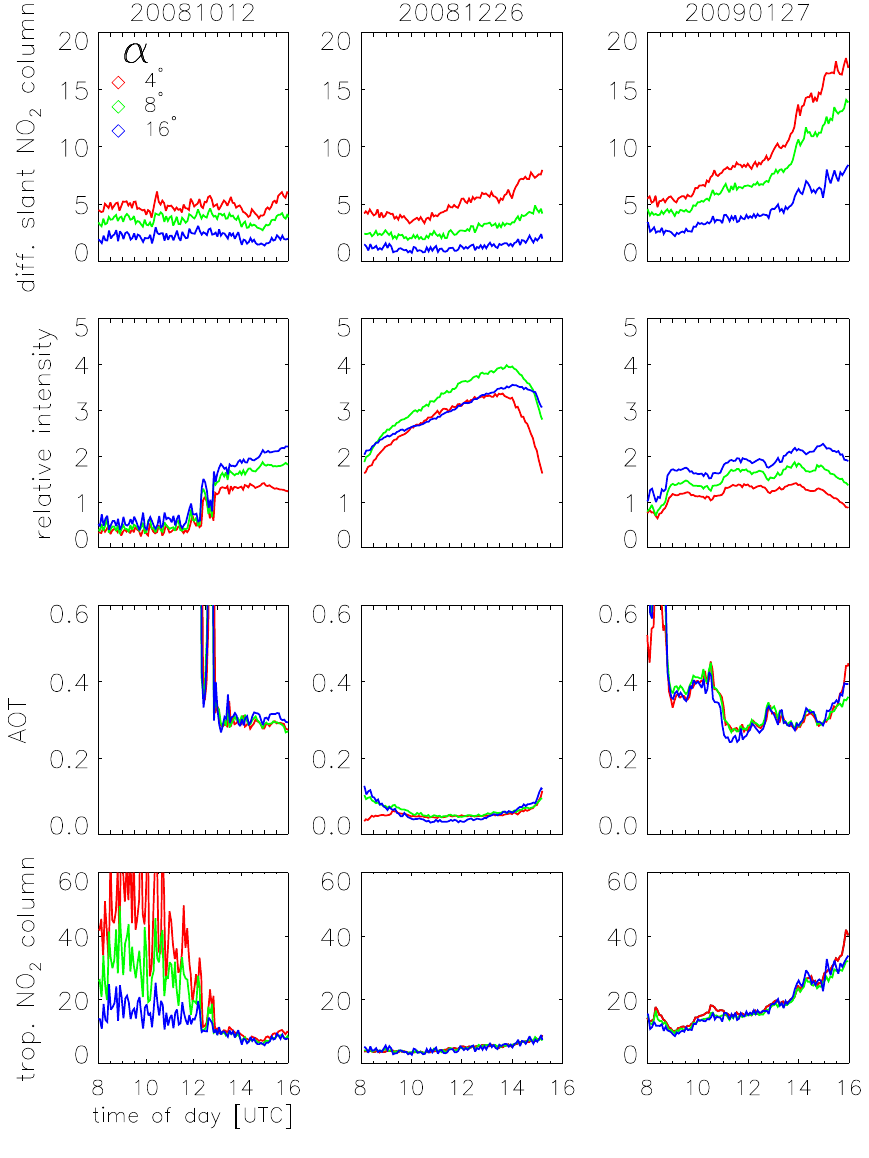
Fig. 10. Tropospheric NO 2 column retrieval for three selected days using the two-step algorithm. All plots have the same time scale on the horizontal axis and in each plot the colors correspond to the elevations indicated by the legend on the upper left. The first row shows the measured NO 2 differential slant columns in [10 16 molecules / cm 2 ]. The second row shows the relative intensities, and the third row the retrieved AOT. The last row shows the retrieved tropospheric column of NO 2 in [10 15 molecules / cm 2 ].